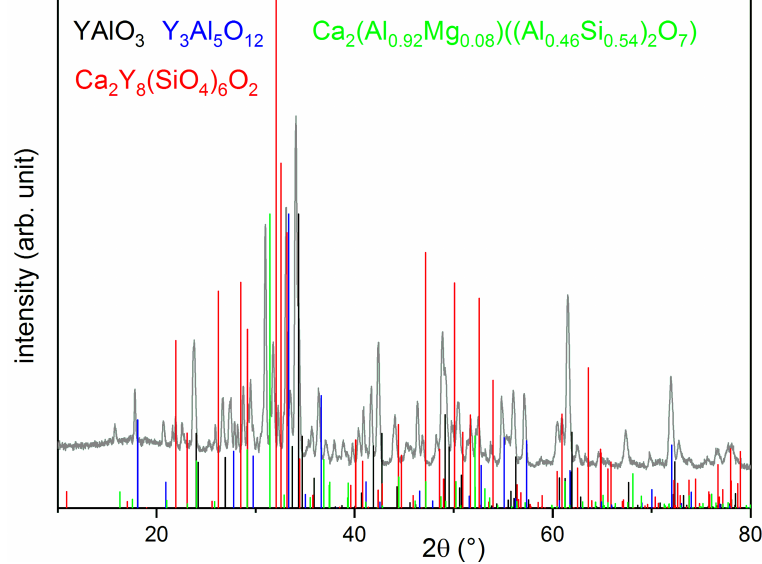
Figure 12. Measured XRD (grey) of VLPPS YAlO 3 coating after 274 cycles in CMAS test and theoretical diffraction patterns of YAlO 3 (black), Y 3 Al 5 O 12 (blue), Ca 2 (Al 0.92 Mg 0.08 )((Al 0.46 Si 0.54 ) 2 O 7 ) (green), and Ca 2 Y 8 (SiO 4 ) 6 O 2 (red).